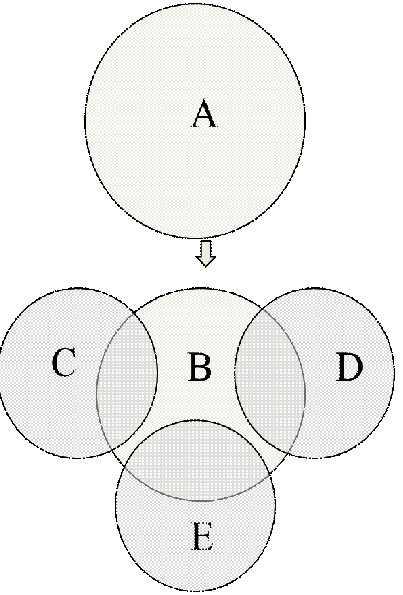
A diagrammatic visualization scheme for the correlation of antioxidant activities and antioxidant content. (A) Plants with high Antioxidant activity: 1, 2, 3, 4, 5, 6, 8, 10, 11, 13, 14, 15, 16, 18, 19, 20, 23, 26, 31, 33, 34, 36, 38, 39, 40, 41, 42, and 43; (B) Plants with high antioxidant activity and also contain significant antioxidant constituents: 1, 2, 3, 4, 5, 6, 8, 10, 13, 14, 15, 16, 18, 20, 23, 26, 31, 33, 34, 36, 38, 39, 40, 41, 42, and 43; (C) Plants with medium to high Phenolic content: 6, 13, 16, 20, 31, 33, 34, 41, 42, and 43; (D) Plants with medium to high Flavonoid content: 1, 4, 6, 8, 13, 16, 20, 29, 31, 33, 34, 36, 38, 41, 42, and 43; (E) Plants with medium to high Trace metal content: 2, 5, 10, 14, 15, 18, 23, 26, 27, 28, 31, 34, 37, 39, 40, 41, and 43. (Note: The names of the plants corresponding to the numbers in the legend are given in Table 1).